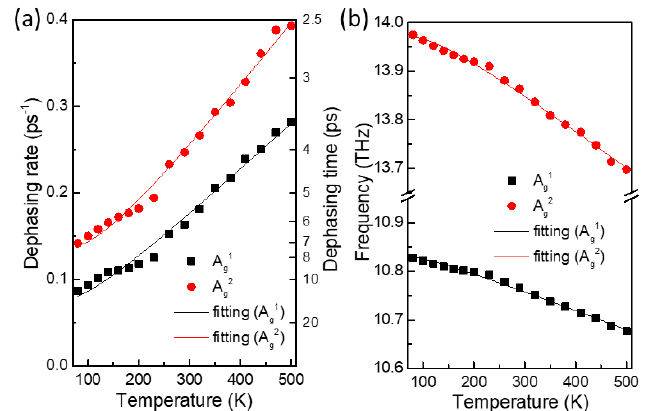
Figure 5. ( a ) Dephasing rate and ( b ) frequency of the A g1 and A g2 mode CP oscillations as a function of temperature. The solid lines are fittings based on the anharmonic phonon decay process into two half ‐ frequency acoustic phonons.